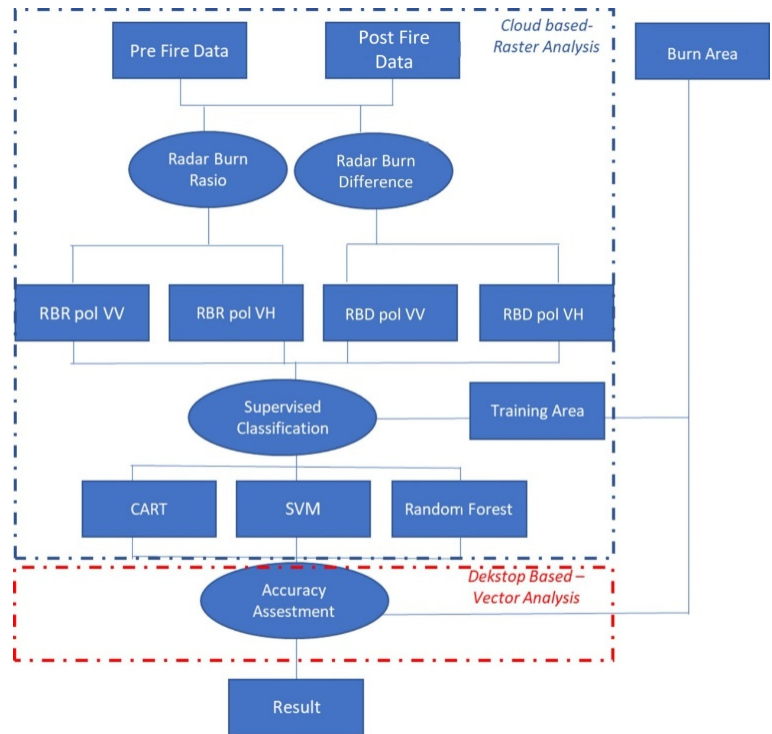
Figure 3. Flow chart of the burnt area identification process using cloud computing.